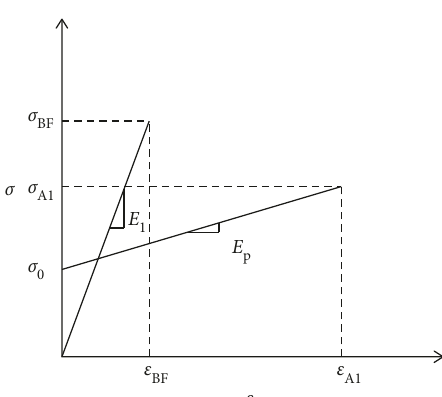
Figure 5: Idealized material behavior for 2A12 aluminum alloy and